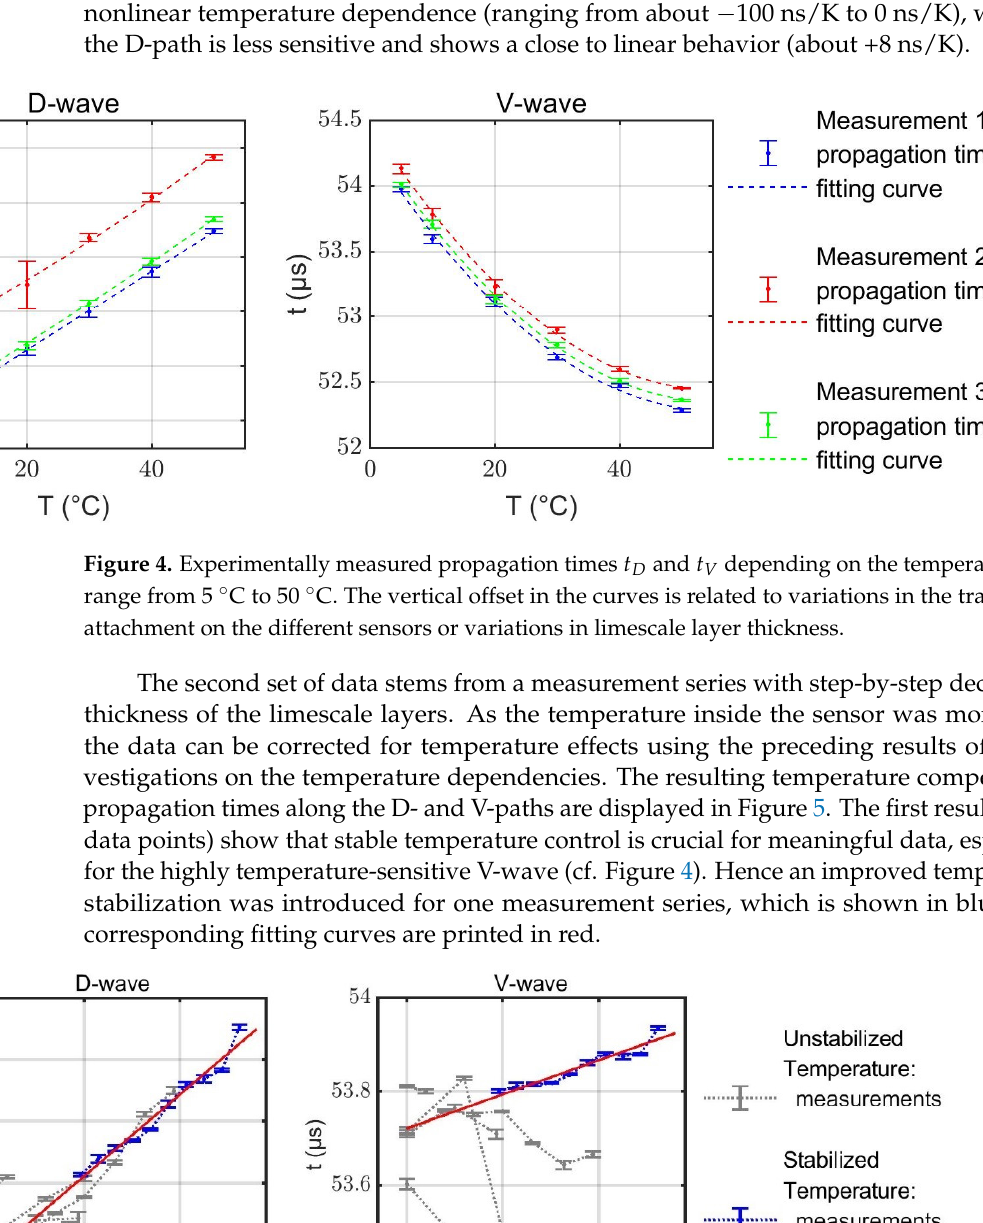
Figure 5. Experimentally measured propagation times t D and t V as a function of the limescale layer thickness. A total of six layers are incrementally removed with acid and measurements are made at intermediate steps. Attempts are made to compensate for temperature fluctuations according to the previous results. In the last measurement (red), the temperature was kept as constant as possible, leading to an improved result.